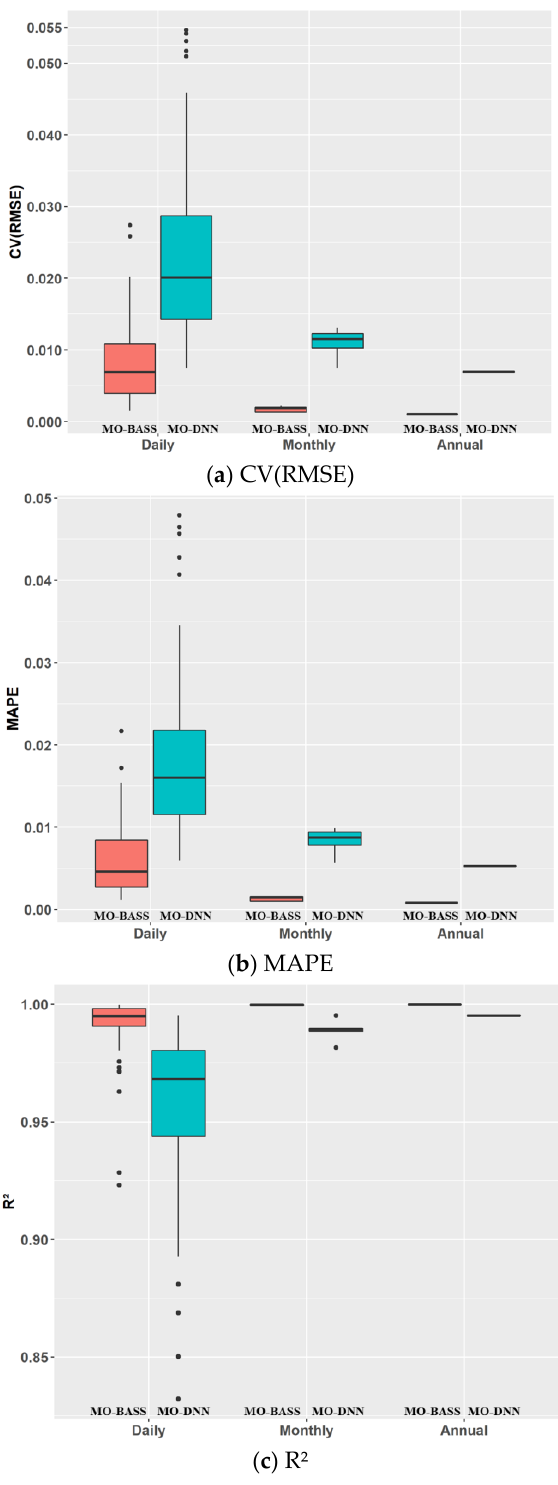
Figure 9. Prediction performance of two machine learning models for multi-time scales cooling en- ergy.